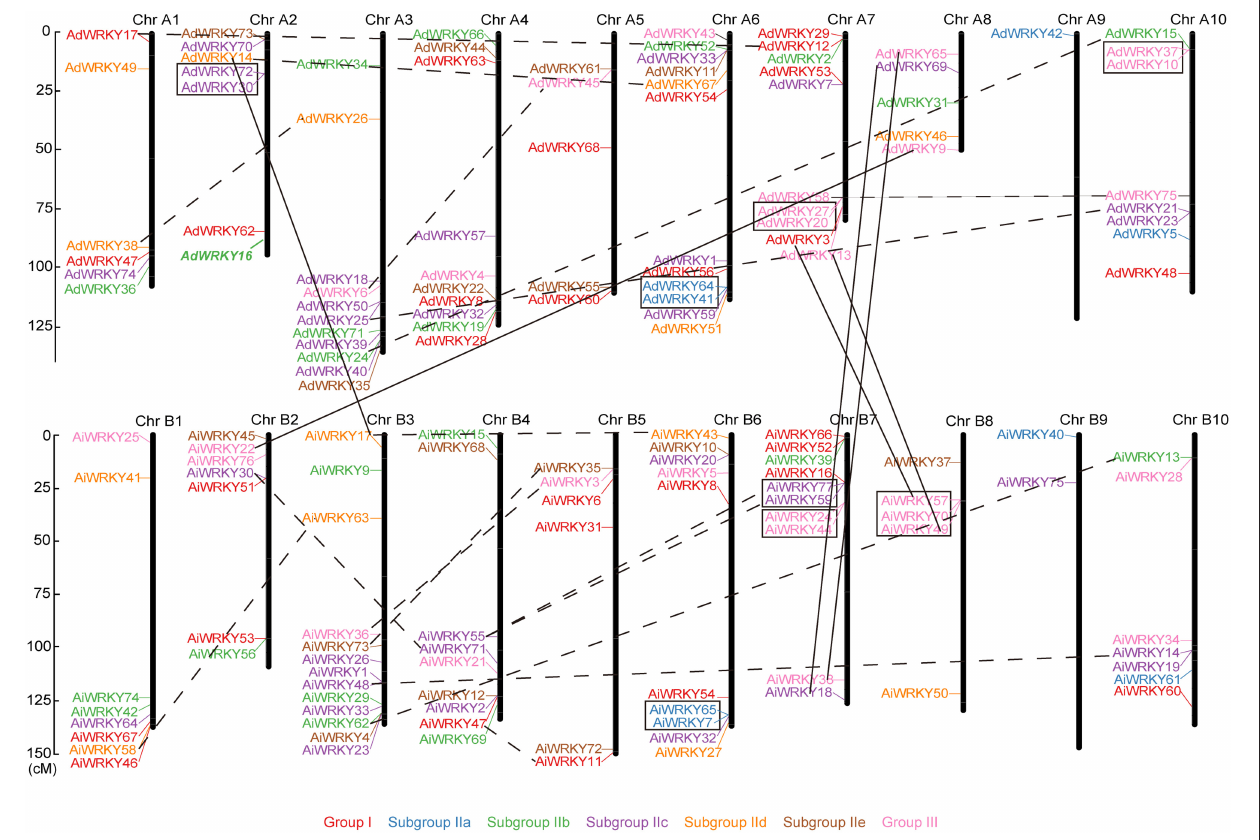
FIGURE 2 | Chromosomal location of AdWRKY and AiWRKY genes. The chromosome numbers were shown at the top of each chromosome (black bars). The location of each WRKY gene was pointed out by a line. The solid lines indicated orthologous genes locations on the two peanut species’ chromosomes. The dotted lines indicated the segmental duplicated genes. The black boxes indicated the tandem duplication genes. Italic indicated predicated chromosomal location in this study.